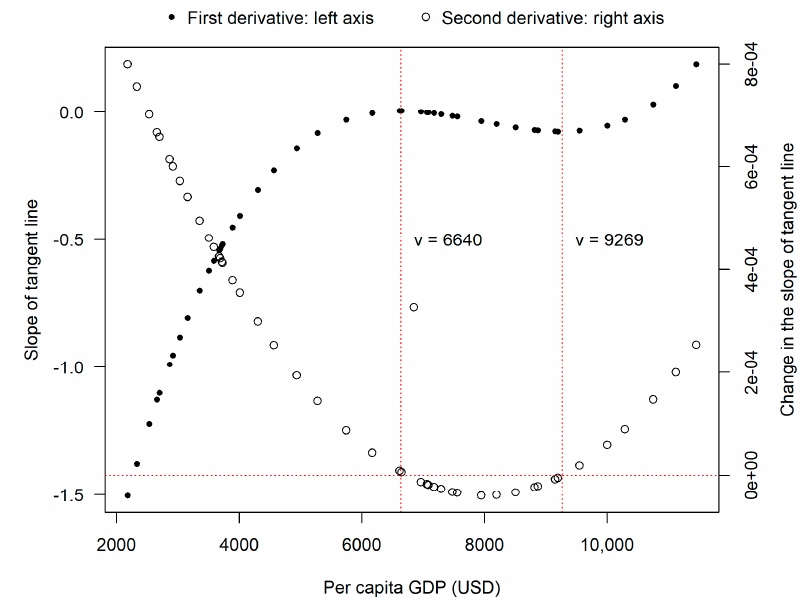
Figure 5. First- and second-order derivatives of quartic function.